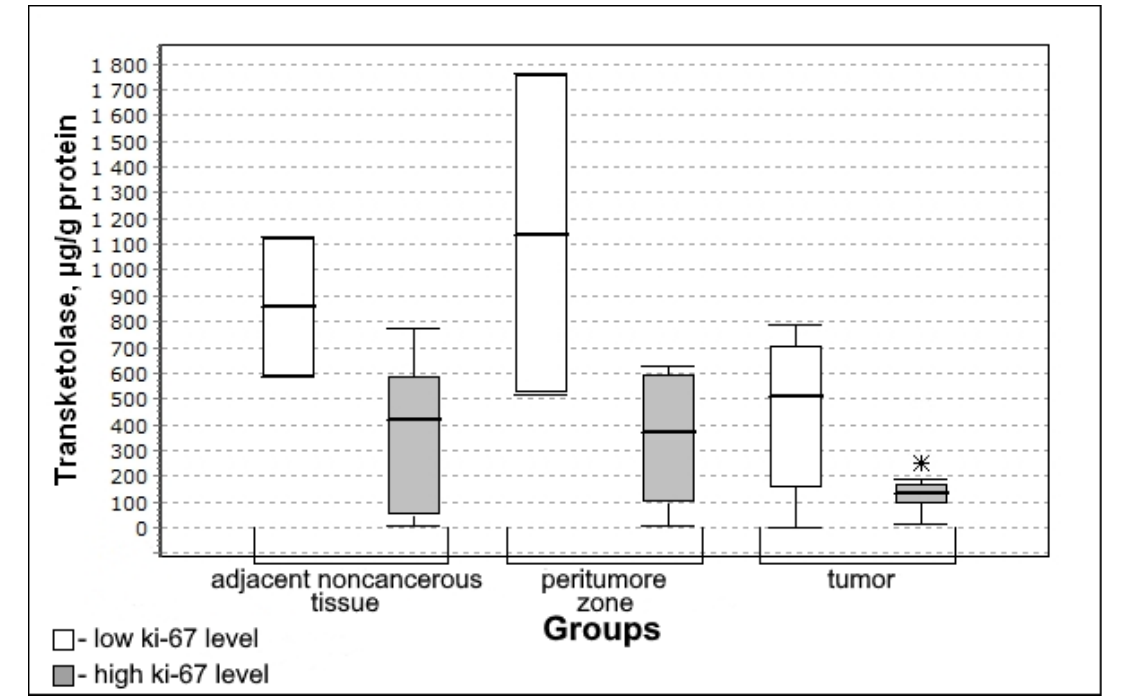
Figure 5. Medians and interquartile ranges (IQR) of the content of transketolase in the tissue of gliomas depending on the magnitude of the mitotic index Ki-67 (low Ki-67 n = 7; high Ki-67 n = 13). Statistics are reported * p < 0.05.